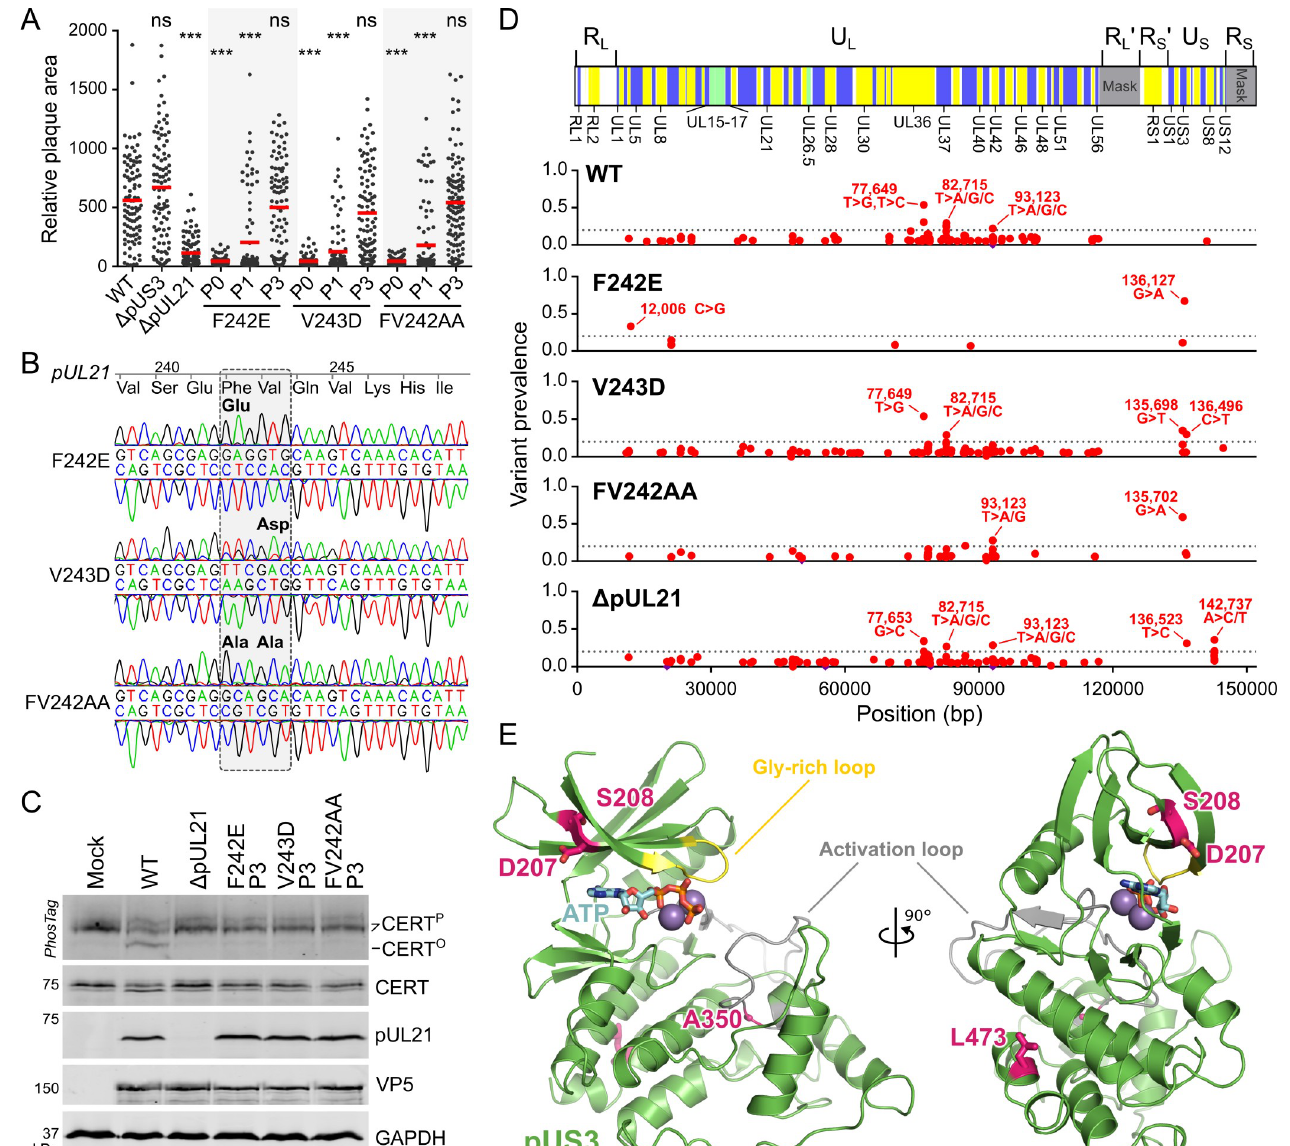
Fig 4. Mutant HSV-1 where PP1 binding of pUL21 is abolished adapts rapidly to cell culture via compensatory mutations in the kinase gene US3. ( A ). Monolayers of Vero cells were infected with 100 pfu of wild-type (WT), Δ pUS3 and Δ pUL21 HSV-1 or with pUL21 point mutant viruses, harvested immediately following transfection of the recombinant BAC into Vero cells (P0) or following amplification for one (P1) or three (P3) generations in Vero cells. Infected cells were overlaid with medium containing 0.6% carboxymethyl cellulose and incubated for 48 h before fixing and immunostaining with chromogenic detection. Relative plaque areas (pixels) were measured using Fiji. Mean plaque sizes (red bars) were compared to WT using one-way ANOVA with Dunnett’s multiple comparisons test (n = 96–113; ns, non-significant; � , P > 0.05; �� , P < 0.01; ��� , P < 0.001) and images used for quantitation are shown in S3 Fig. ( B ) Sanger sequencing of pUL21 region, amplified by PCR from P3 stocks of virus, show that the introduced point mutations have not reverted to the wild-type sequence. ( C ) Vero cells were mock-infected or infected at MOI = 5 with WT HSV-1, Δ pUL21 virus or with P3 stocks of pUL21 point mutants shown. Lysates were harvested at 16 hpi and subjected to SDS-PAGE plus immunoblotting using the antibodies listed. The upper strip depicts SDS-PAGE where PhosTag reagent was added, retarding the migration of hyperphosphorylated CERT (CERT P ) versus the hypophosphorylated protein (CERT O ). The P3 stocks of all pUL21 point mutant viruses retain pUL21 expression but all lack the ability to promote CERT dephosphorylation, indicating that PP1 binding has not been restored. ( D ) Prevalence of sequence variants in P3 stocks of pUL21 point mutants and Δ pUL21 when compared to similarly passaged WT HSV-1 as assessed by next-generation sequencing. Top : Schematic representation of the HSV-1 genome is shown with alternating background colouring corresponding to HSV-1 genes, green denoting overlapping reading frames, and with selected genes labelled. Repeat regions excluded from the mapping of sequences ( Mask ) are shown in grey. U L and U S denote the unique long and unique short segments, respectively, R L /R L 0 are the inverted repeats bounding U L and R S /R S 0 are the inverted repeats bounding U S . Bottom : Non-synonymous variants (red) and insertions/deletions (purple) are shown across the HSV-1 coding sequences. Dotted grey line denotes 20% prevalence and selected high-prevalence variants are labelled. Mutations introduced into pUL21 by